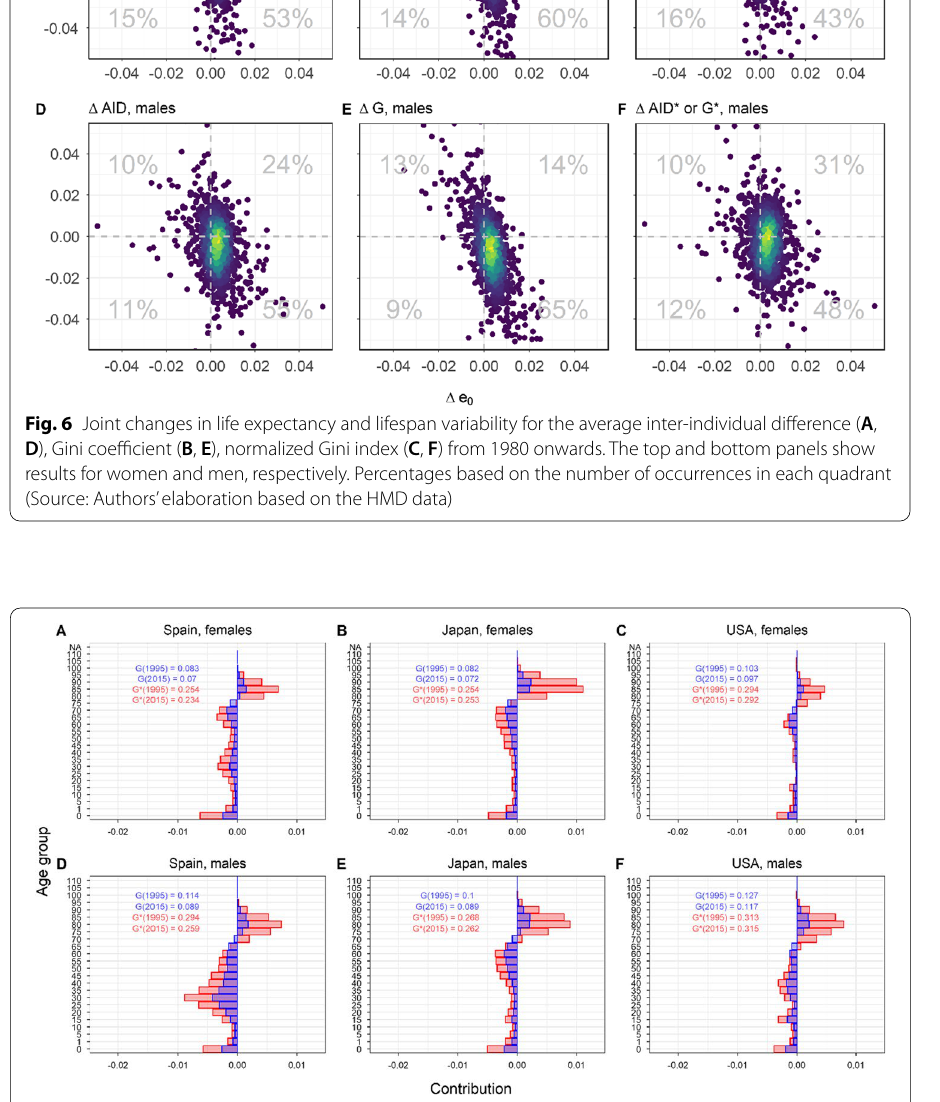
Fig. 7 Age-specific decompositions of lifespan inequality change for females (top row) and males (bottom row) in Spain, Japan, and the US between 1995 and 2015. The blue bars show the age-specific contributions for the Gini index and the red ones for the normalized Gini index (Source: Authors’ elaboration based on the HMD